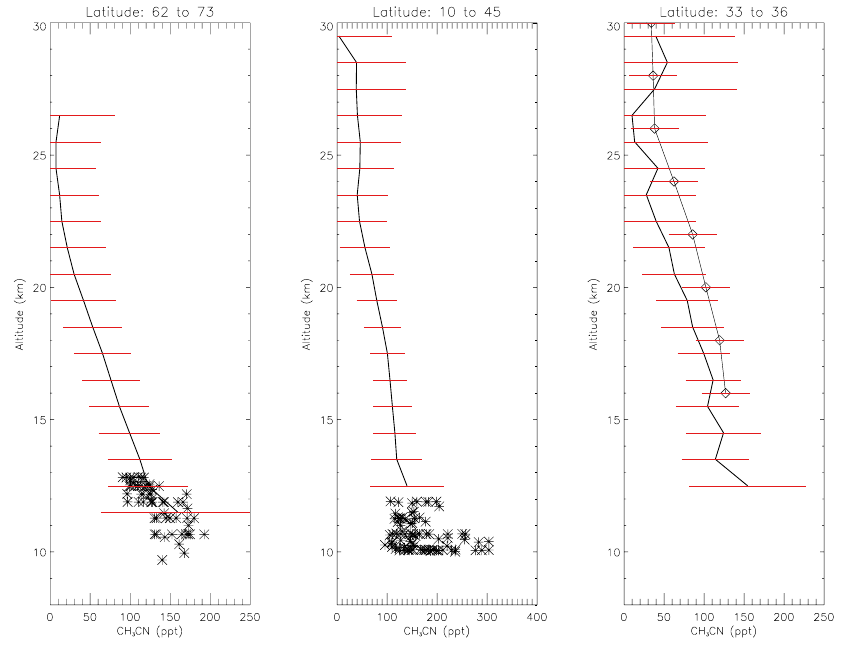
Fig. 4. Left: STREAM data in the lower stratosphere at latitudes between 62 and 73 ◦ N, taken directly from Fig. 3 of Schneider et al. (1997), superimposed on a median ACE profile over the same latitude range. Middle: TRACE-P data in the upper troposphere (10–12km) over the latitude range 10–45 ◦ N, taken directly from Fig. 2 of Singh et al. (2003), superimposed on a median ACE profile over the same latitude range. Right: The average of six MkIV profiles between 33 and 36 ◦ N (1993–1996 and 2003–2004), taken directly from Fig. 2 of Kleinb¨ohl et al. (2005), superimposed on a median ACE profile over the same latitude